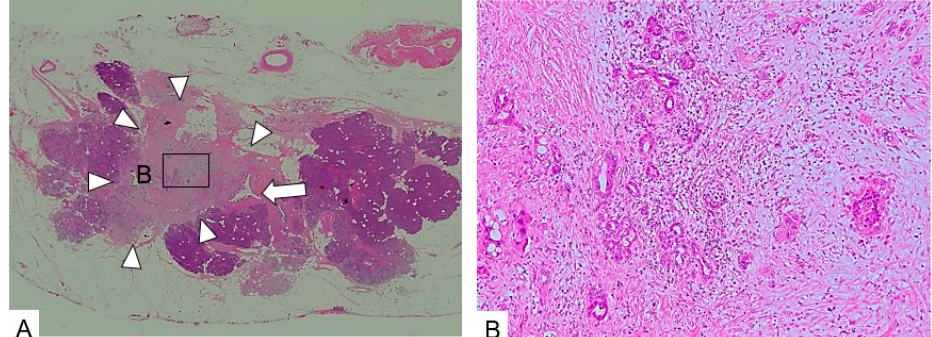
Figure 9. Parenchymal tumor type. ( A ). A tumor with an irregular margin is recognized (arrow heads) without invading the main pancreatic duct (arrow). The main pancreatic duct has a fibrously thickened wall, which is in contact with the tumor, but has not been invaded. ( B ). The tumor consists of dense fibrous stroma with cancer pseudoglands. (H.E., ×100).